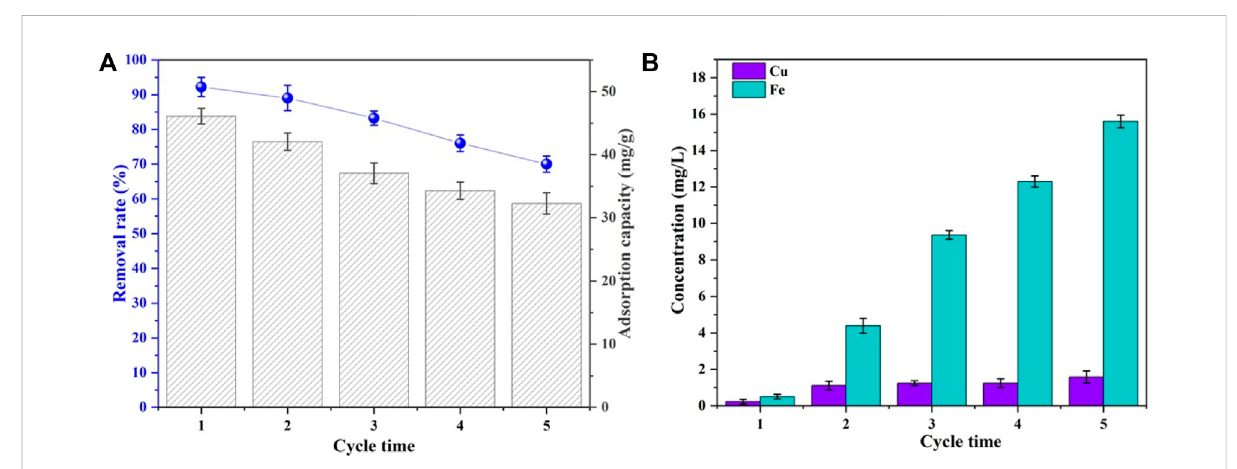
FIGURE 5 Removal rates and adsorption capacity (A) and leaching of Cu and Fe at each cycle of CSBC (B)